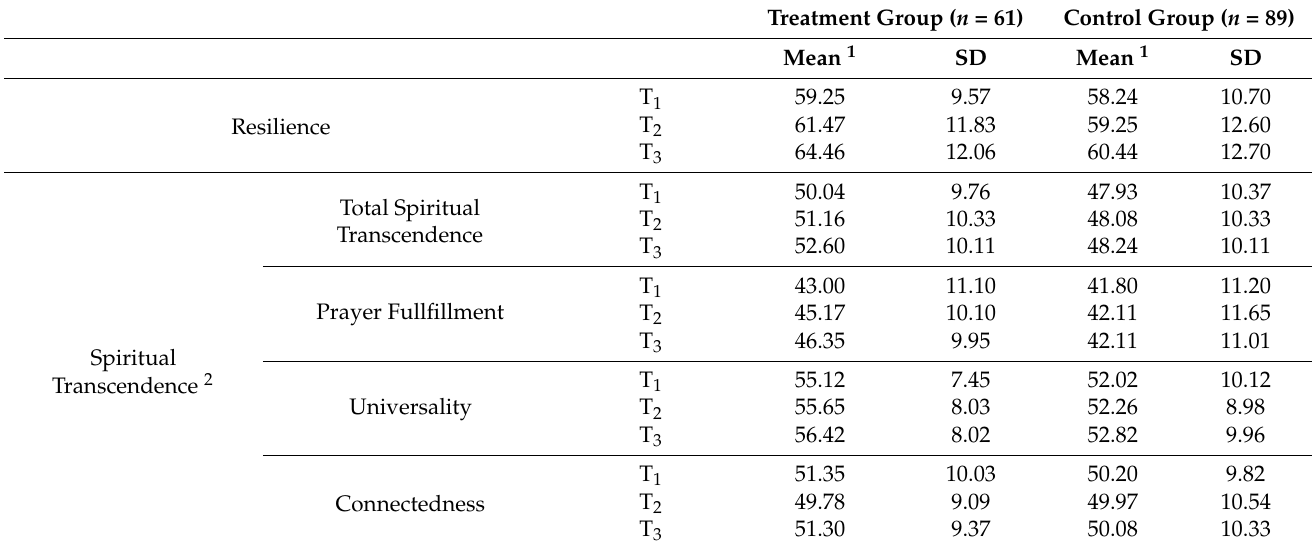
Table 1. Univariate Descriptive Statistics for Response to Stressful Events Scale (RSES) total scores and Spiritual Transcen- dence Scale (STS) broken out by